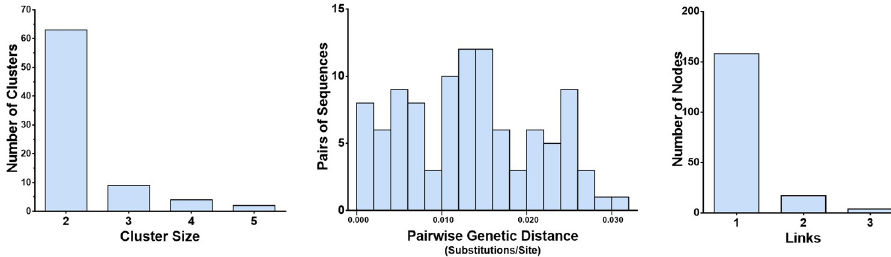
Fig 2. Characteristics of the HIV-1 molecular network in Baoshan Prefecture. A, Distribution of genetic transmission clusters by cluster size. B, Distribution of sequence pairs by genetic distance. C, Distribution of nodes in clusters by